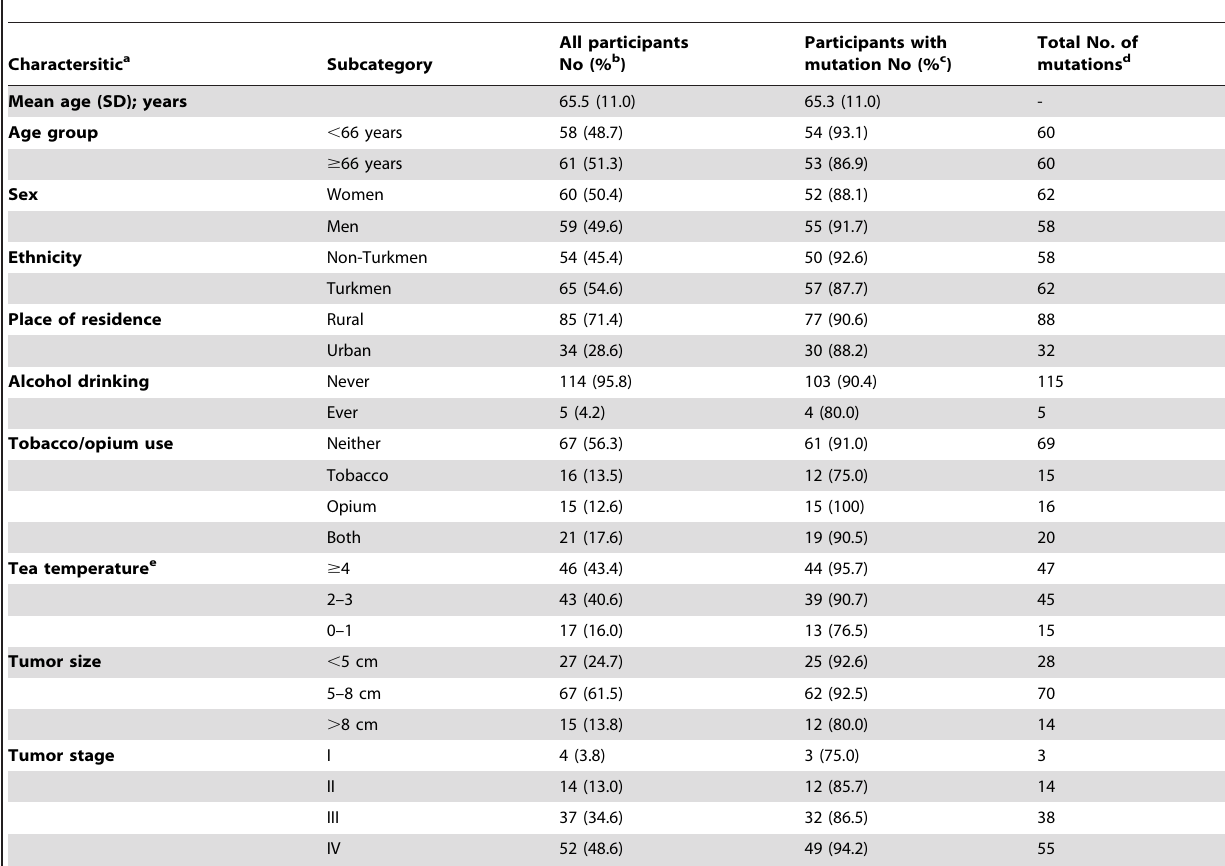
Table 1. Number of participants and mutations by demographic, lifestyle, and tumor